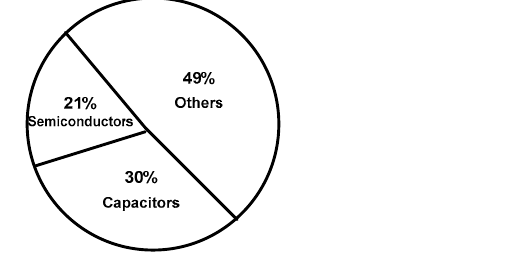
Figure 19. Distribution of failures between components of power electronic converters [40,41].